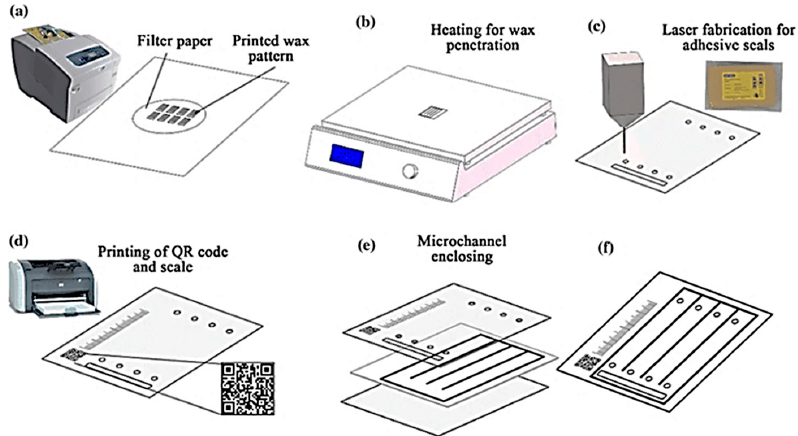
Figure 11. Schematic of the microchannel fabrication and microchannel enclosing using wax printing and laser cutter where (a) printing wax pattern on a fiter paper, (b) heating step to penetrate wax through paper, (c) laser fabrication for adhesive seals, (d) inkjet printing of QR code and scale (e) enclosing microchannels by combining device layers, and (f) final device construct. (Adapted with the permission from Springer Nature) [68].